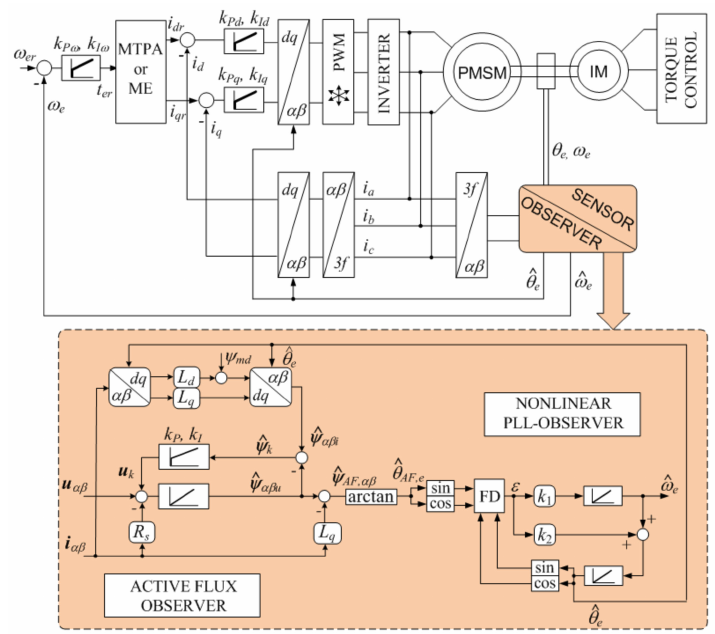
Figure 9. Schematic presentation of the applied speed closed-loop control.